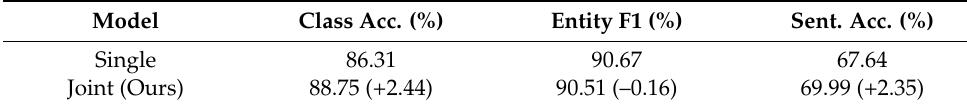
Table 3. Comparison results of single model and joint